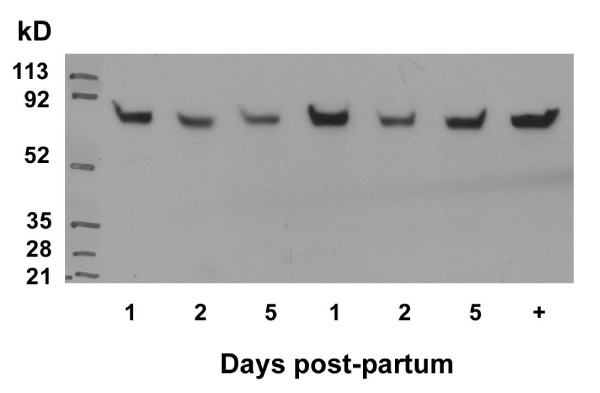
Western blotting of FSH receptor in ovarian tissue from neonatal rats. Ovaries were collected at defined times post-partum and processed as described in the Methods (n = 3-4 animals/day). Each lane represents and individual animal. "+" - positive control: ovarian tissue collected 48 hours post-PMSG.